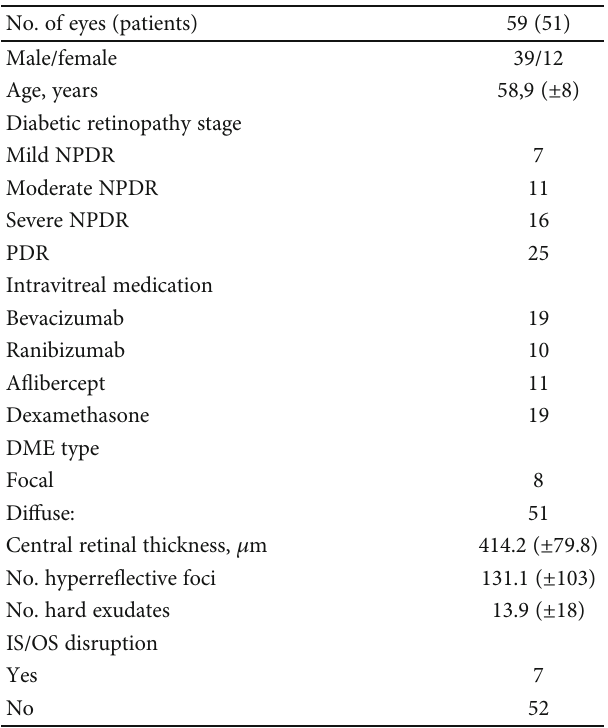
Figure 1: Multimodal imaging of a nonvascularized outer retinal layer (ORL) hyperre fl ective foci (HF). Figure shows the distribution of a HF in a 42-year-old patient with proliferative diabetic retinopathy (PDR) at baseline. Upper panel: HF in the absence of any visible HE on corresponding color fundus photographs (CFP) could be detected. Higher magni fi cation image of the macular area marked with a dashed square. Lower panel: visualization of an outer nuclear layer HF adjacent to a cystoid space on optical coherence tomography (OCT) B- scan with manual segmentation of the vascular slabs of this region visualized as dashed red lines (left). Corresponding en face OCT- angiography (OCTA, right) image of the manually outlined vascular slab con fi rms, which the HF is not attached to blood vessels. HF border is outlined in yellow and area in mm 2 is calculated by the device software. Table 1: Baseline characteristics of 40 diabetic study